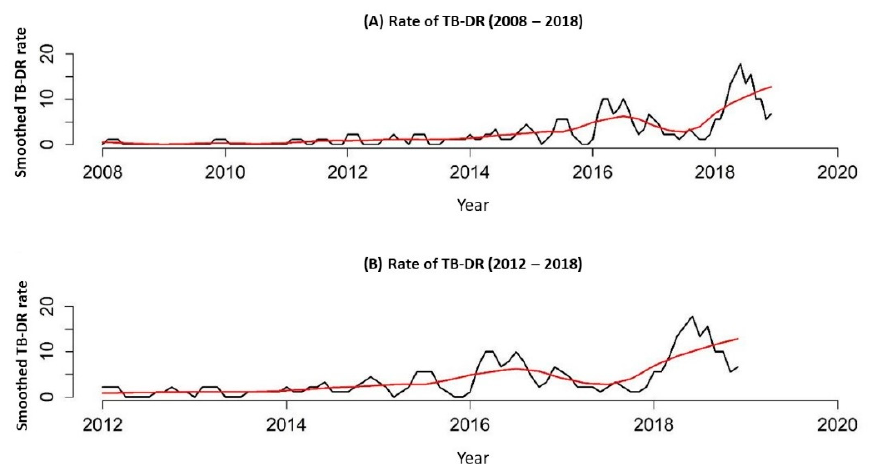
Figure 2. DR-TB rate in the liberty-deprived population of the state of Paraná, Brazil, 2008 to 2018. ( A ), DR-TB rate in the liberty-deprived population of the state of Paraná, Brazil, 2008 to 2018; ( B ) DR-TB rate in the liberty-deprived population of the state of Paraná, Brazil, 2012 to 2018. When calculating the simulated ARIMA, an increasing trend was observed for the coming years that remained within the 95% confidence interval, as shown in Figure 3.